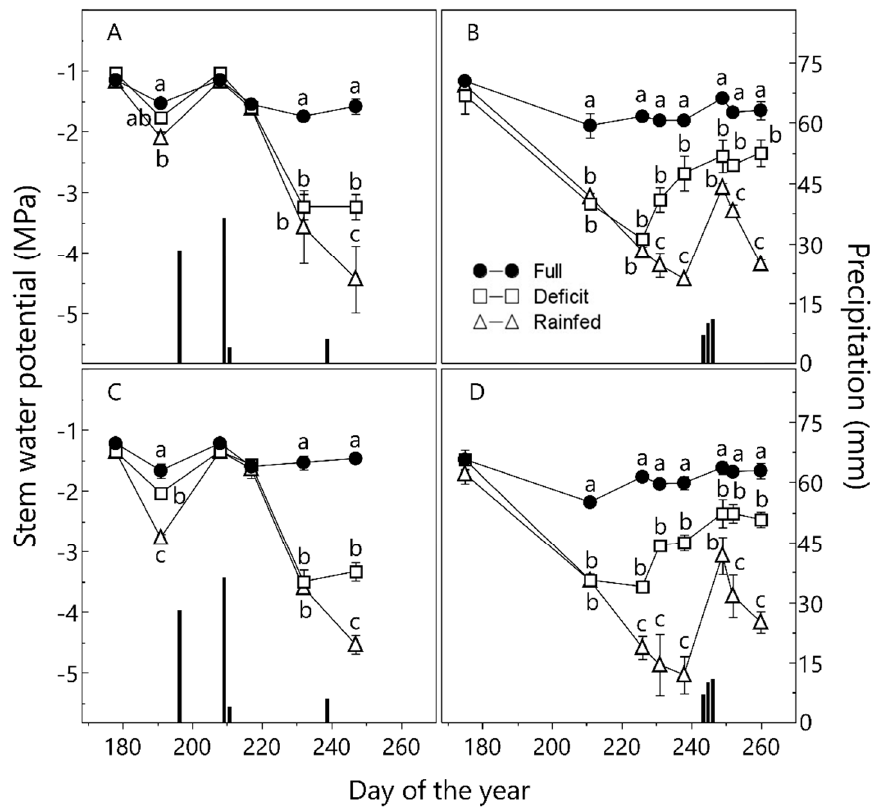
Figure 2. Seasonal course of stem water potential of olive trees of cultivar Frantoio ( A , B ) and Leccino ( C , D ) subjected to full irrigation, deficit irrigation, or rainfed conditions in 2019 ( A , C ) and 2020 ( B , D ). Histograms represent precipitations. Symbols are means ± standard deviations of three trees. Different letters indicate significant differences between irrigation treatments after an analysis of variance (ANOVA, p < 0.05) within each date of measurement.